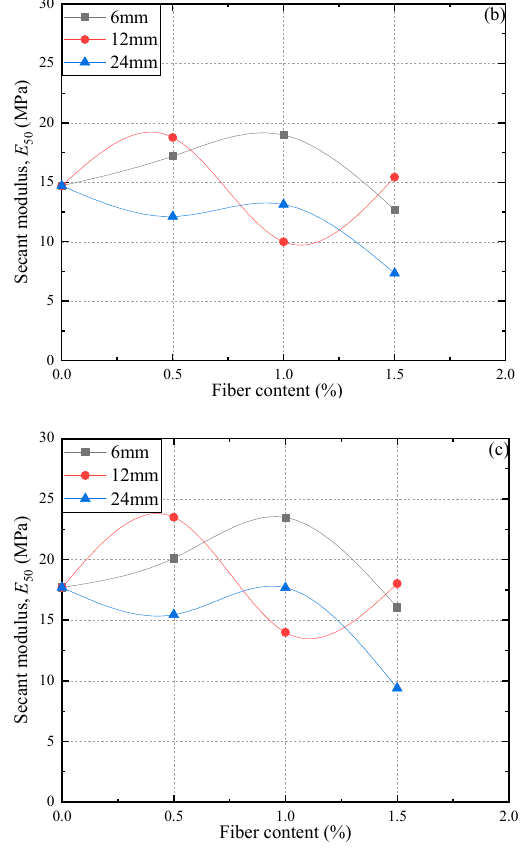
Figure 7. The relation curves of different FC, FL, and secant modulus, E 50 , for the FAS specimens under various confining pressures: ( a ) 200 kPa, ( b ) 300 kPa, ( c ) 400 kPa.